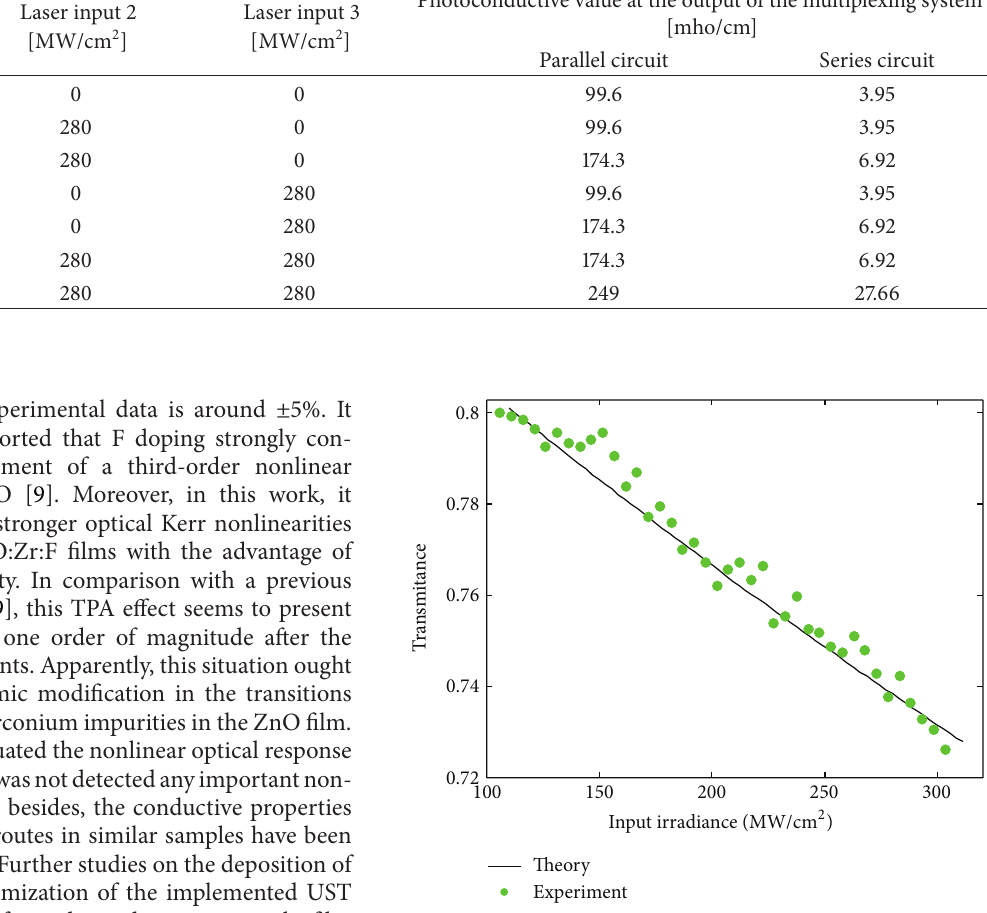
Figure 7: Nonlinear optical transmittance of a single beam in the studied